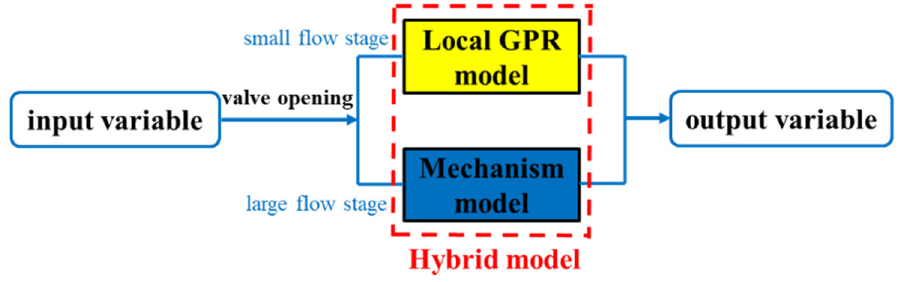
Figure 5. Hybrid model for prediction of the centrifugal pump efficiency.